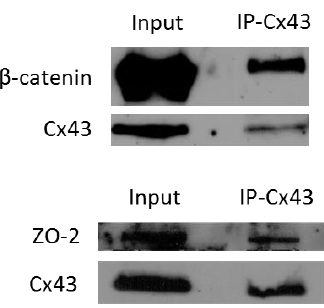
Figure 3. Cx43 assembles GJ complexes in S1 cells under 2-D culture conditions. S1 cells were cultured under 2-D conditions. Total proteins were extracted on day 6. Association of Cx43 and β -catenin (upper panel) or ZO-2 (lower panel) was assessed by coimmunoprecipitation (IP) of Cx43 followed by Western blotting for detection of Cx43, β -catenin and ZO-2. The input served as a control. Three independent experiments were performed for Cx43- β -catenin association and two for Cx43-ZO-2 association.